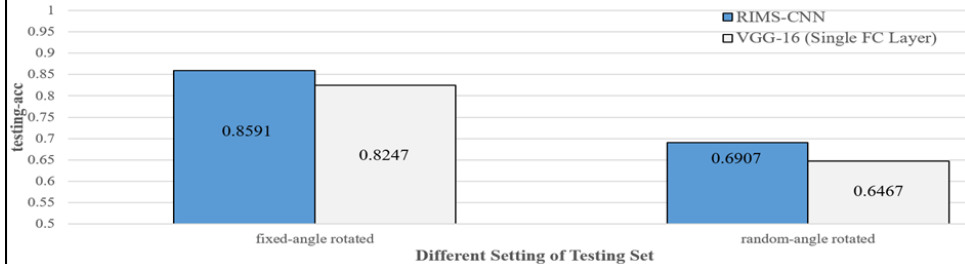
Figure 29. Evaluating RIMS-CNN and VGG-16 on the fixed-angle and random-angle rotated FASH- ION-MNIST.